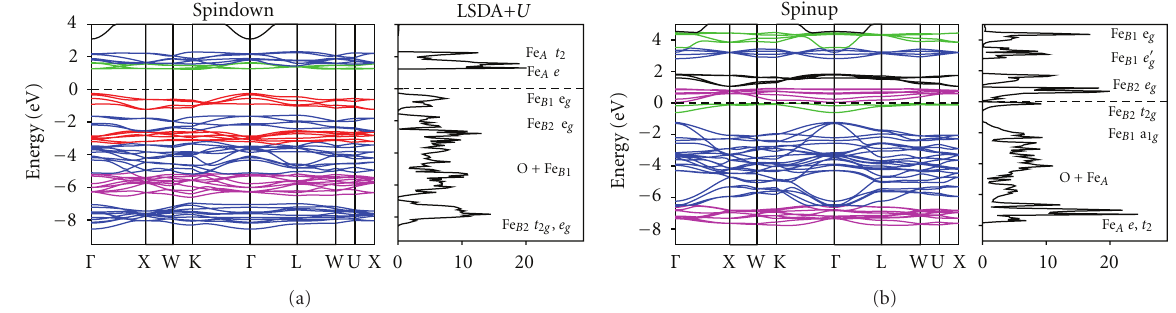
Figure 3: LSDA+ U energy band structure and total DOS (in states/(unit cell eV)) of Fe 3 O 4